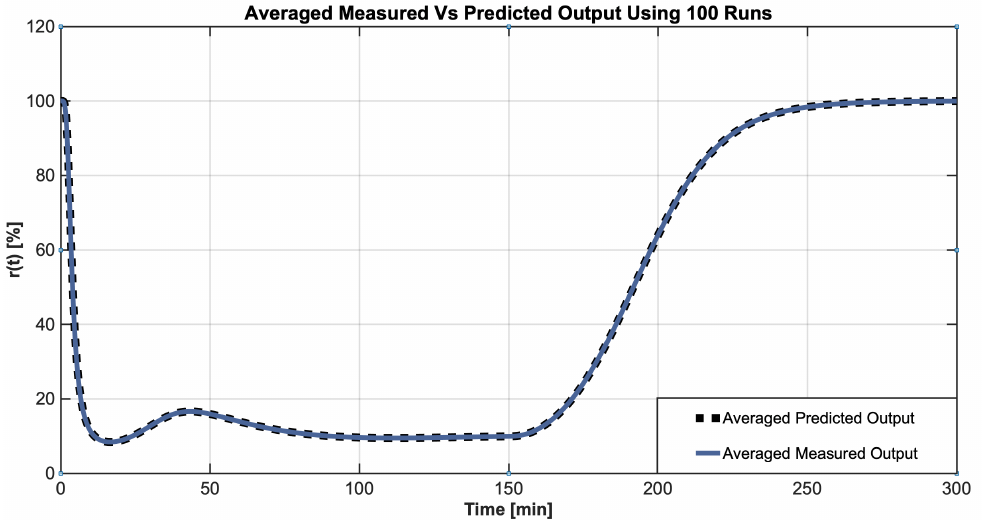
Figure 5. Average measured and predicted NMB outputs over 100 Monte Carlo simulations.